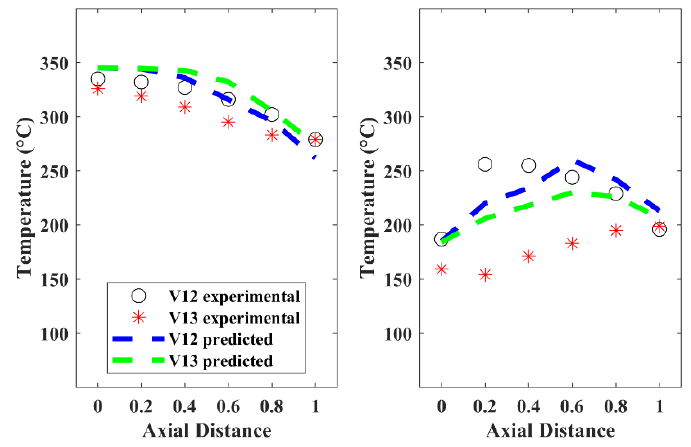
Figure 4. Comparison of predicted temperature profiles against the experimental temperature measurements ( left ) without spray and ( right ) with spray.